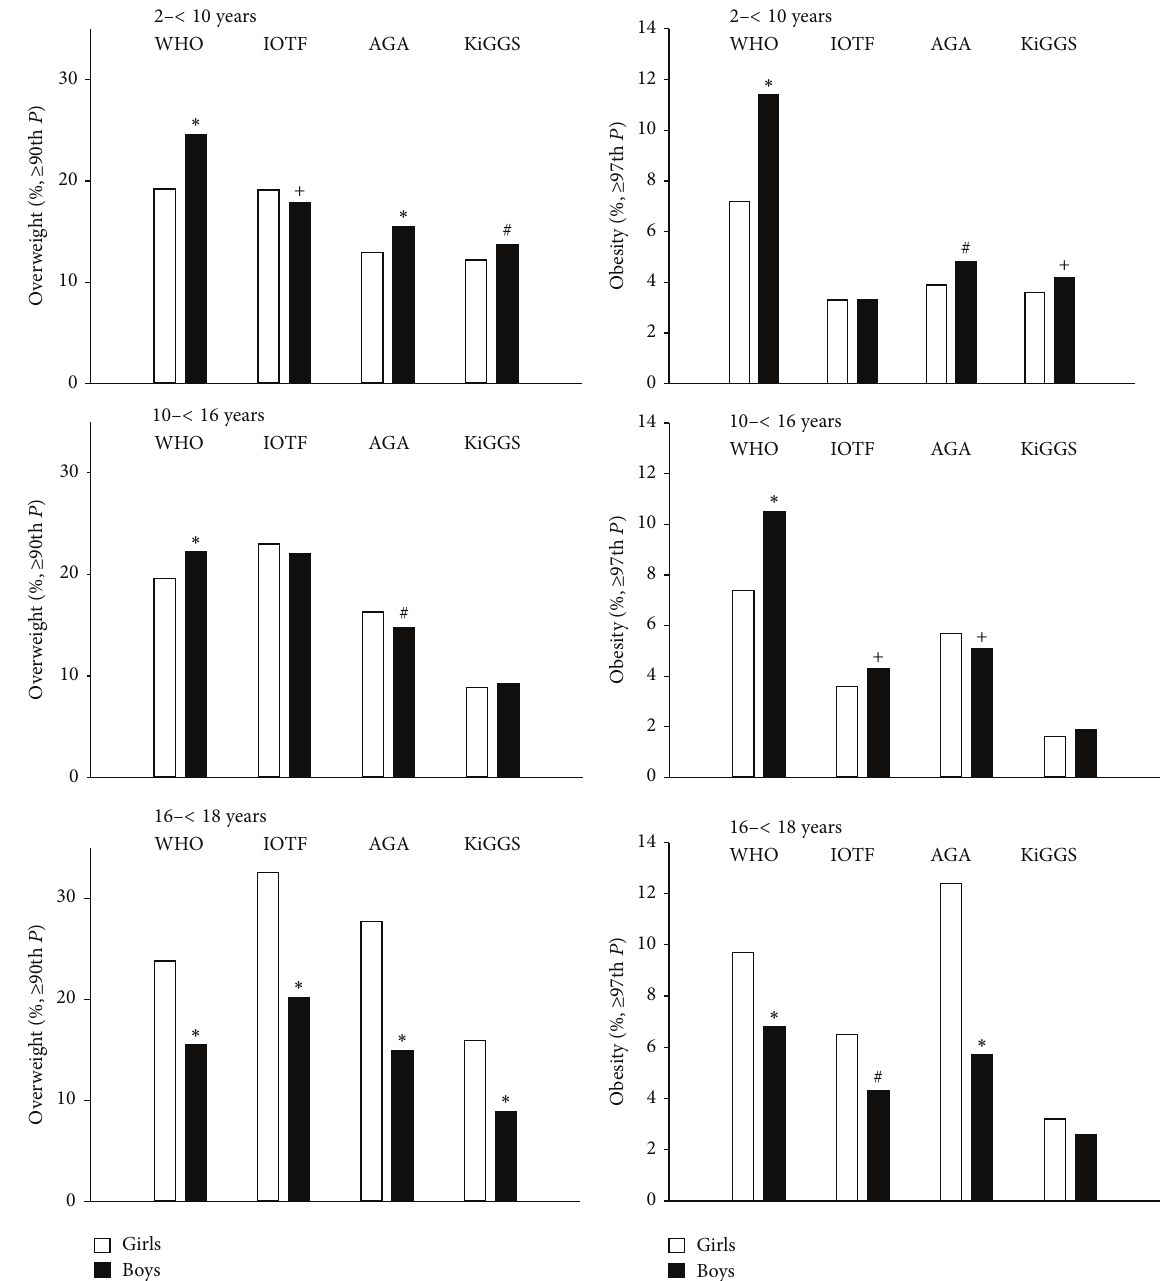
Figure 2: Prevalence (%) of overweight and obesity in girls (empty columns) and boys (grey columns) with T1D based on WHO, IOTF, AGA, and KiGGS reference population according to different age groups. 𝑃 : percentile; ∗ 𝑝 < 0.0001 ; # 𝑝 < 0.001 , + 𝑝 < 0.05 , boys versus girls.